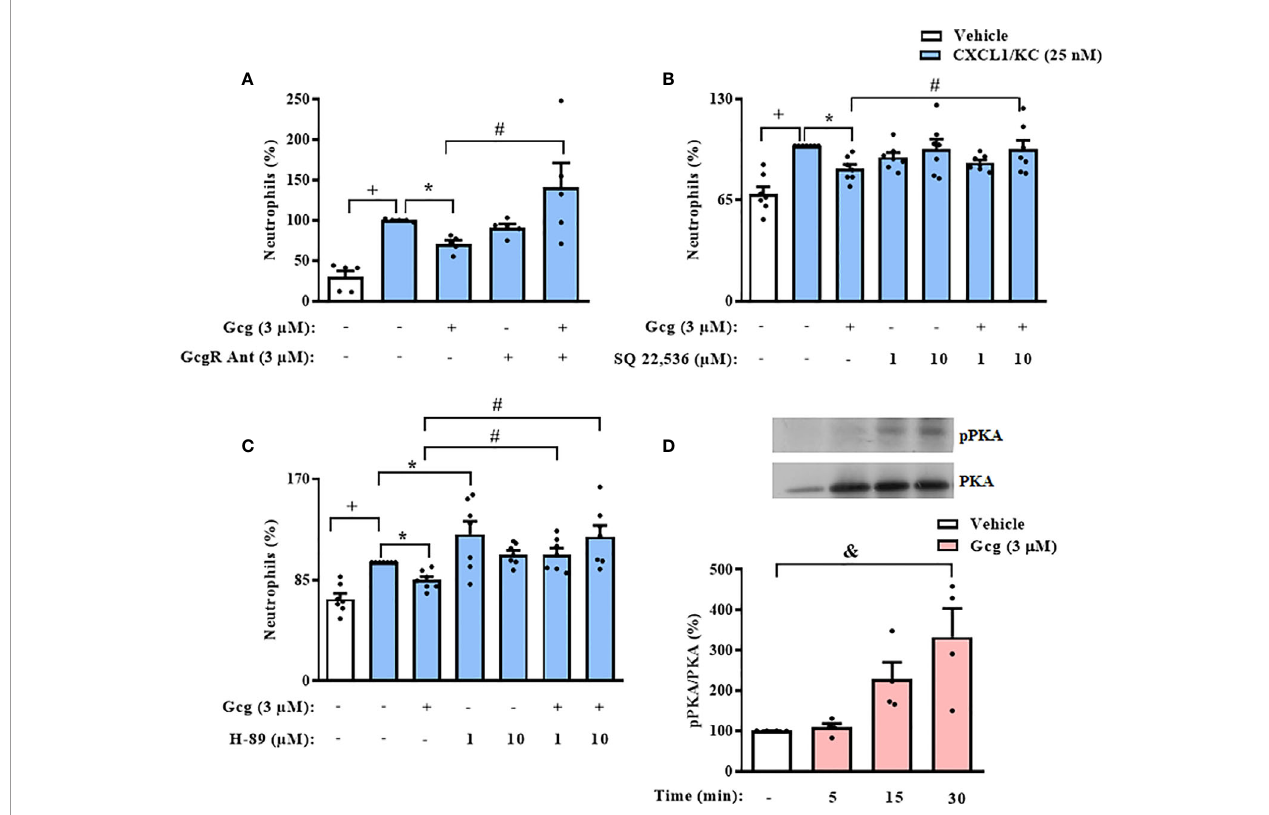
FIGURE 6 | The inhibition of neutrophil chemotaxis by glucagon in vitro depends on the cAMP-PKA pathway. Cells were pretreated 30 min with GcgR antagonist (A) , adenylyl cyclase inhibitor SQ 22,536 (B) , or PKA inhibitor H-89 (C) and, after this, treated with glucagon for 30 min in vitro . Then, cells were let to migrate for 40 min towards CXCL1/KC (25 nM) in a chemotaxis chamber. The vehicles used were DMSO 0.1% to SQ 22,536 or medium to glucagon and H-89. (D) Representative samples of pPKA and total PKA expression in the neutrophils of glucagon-treated (3 µM) cells. The expressions of pPKA and total PKA were determined by western blot. Data were normalized to total PKA. Full-length blots of pPKA and total PKA are reported in Supplementary Figure S6 . Each value represents the mean ± S.E.M. BM-neutrophils obtained from 5 (A) , 7 (B, C) , and 4 (D) random male mice were equally distributed in all experimental groups. The statistical analysis was performed by one-way ANOVA, followed by Newman – Keuls – Student ’ s t-test. Results from (A – C) are representative of two individual assays. Results from (D) are representative of one individual assay. +++ P < 0.001 compared to non-stimulated cells. * P < 0.05 compared to stimulated cells. # P < 0.05 compared to stimulated cells treated with glucagon. & P < 0.05 compared to non-stimulated cells treated with vehicle. Gcg, Glucagon; GcgR Ant, Glucagon receptor